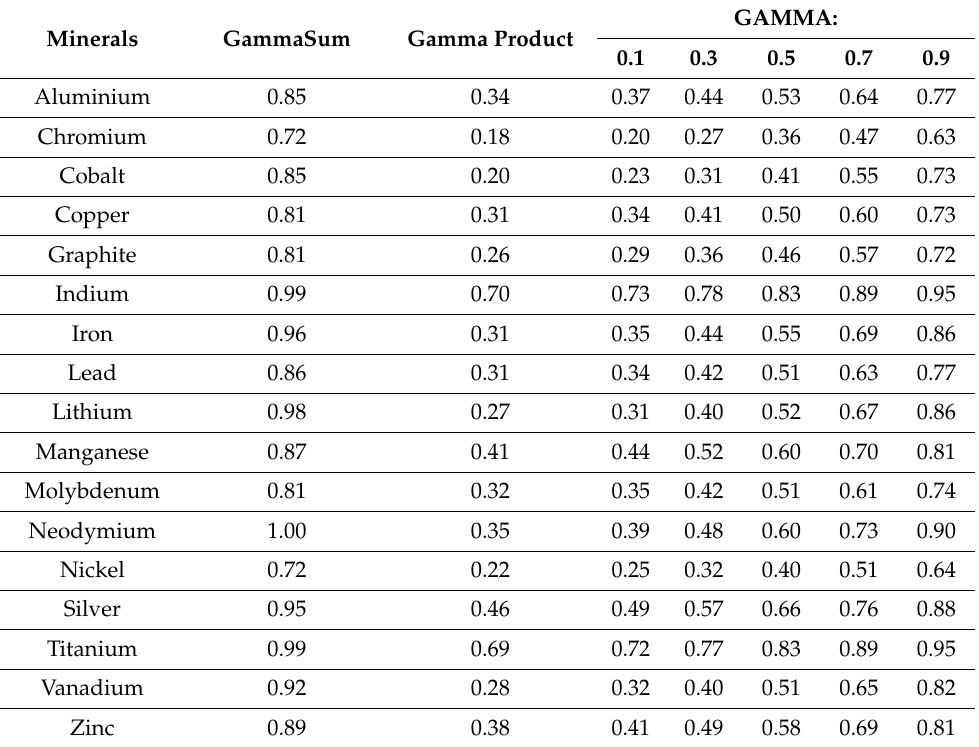
Table 7. Result of calculation of the final level of in Scenario 2 fuzzy model. For a focused view, the results of gamma 0.2, 0.4, 0.6 and 0.8 were removed.